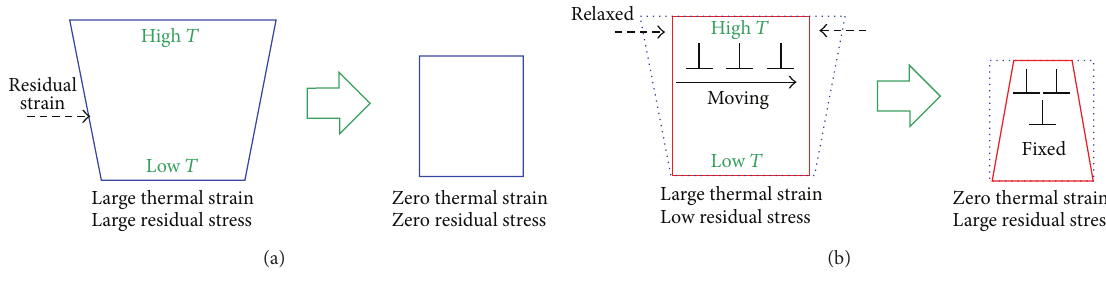
Figure 9: Model of the relationship between the thermal strain and the residual stress. (a) Variation of the residual stress in the elastic body from high temperature to room temperature during cooling process. (b) Variation of the residual stress in the viscoplastic body from high temperature to room temperature during cooling